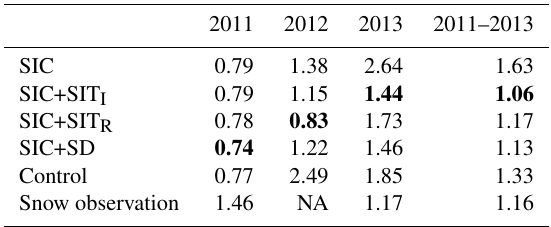
Table 4. The March–April-mean RMSE of the ensemble-mean snow depth averaged over all grid cells. The five experiments and the snow-depth satellite observations are compared to the IceBridge airborne snow-depth observations. Bold values represent the model with the lowest RMSE values for that